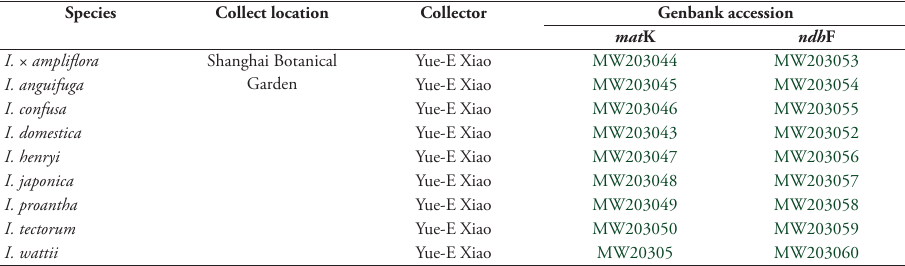
Table A1. Genbank accession of two chloroplast fragments for nine Iris species (Mathew 1981; Goldb- latt and Manning 2008) in the